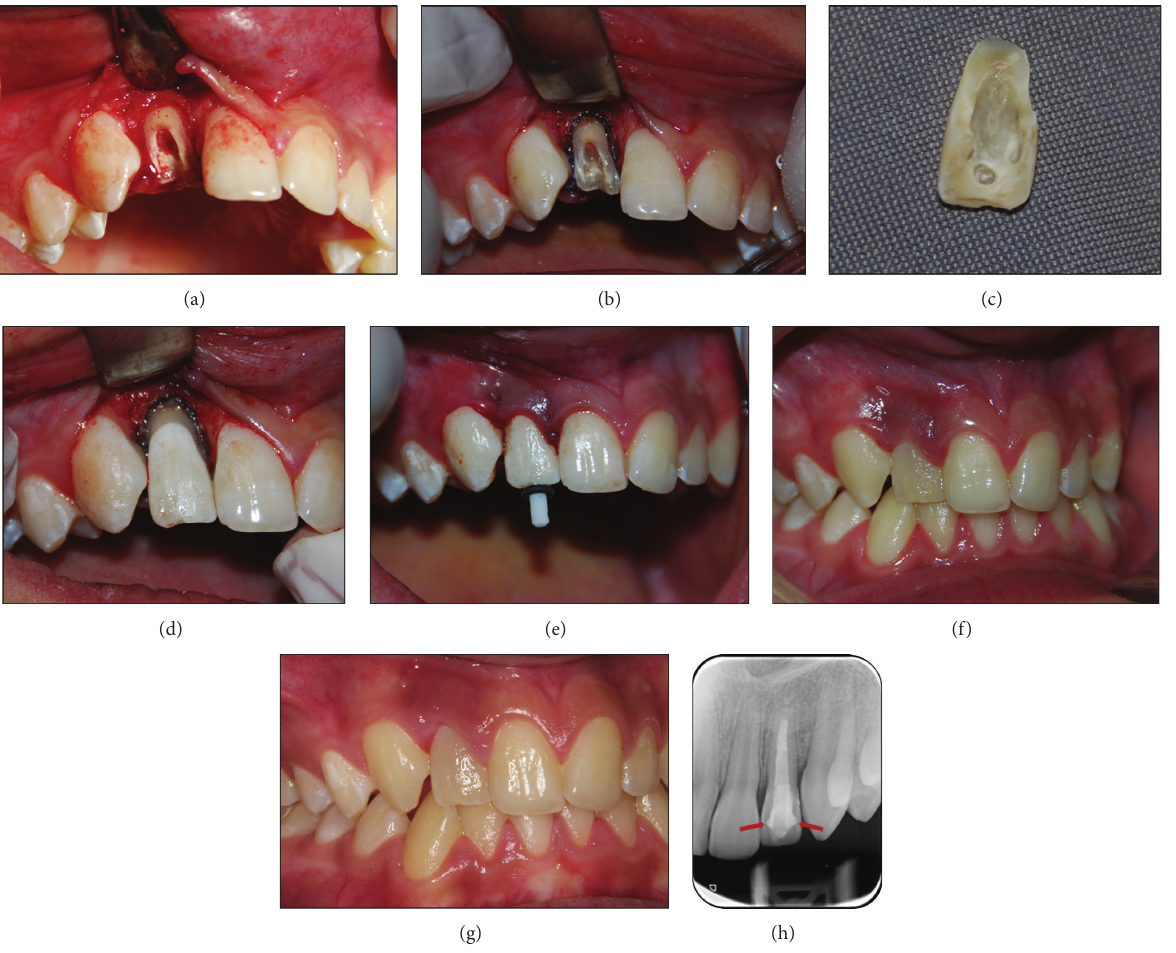
Figure 2: (a) Exposing the fracture line surgically. (b) Retraction cord application. (c) Grooves created on the coronal fragment. (d) Reattachmentofthecoronalfragmentwithadual-curelutingcomposite.(e)Checkingtheadaptationoftheresinfiberpostintotherootcanal. (f) Intraoral view of the 1-week follow-up exam after reattachment. (g) Intraoral view of the 24-month follow-up exam after reattachment. (h) Periapical radiograph of the 24-month follow-up exam showing no pathologic alteration. Notice the grooves in the coronal fragment